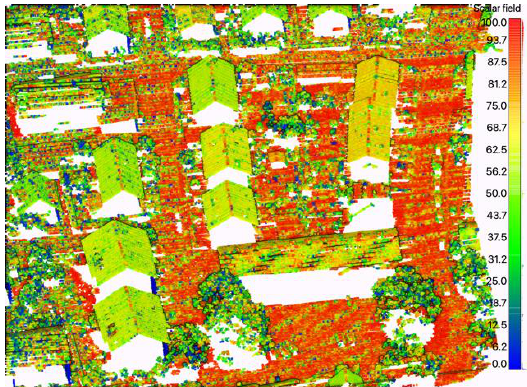
Figure 7. Computed vertical angle feature shown on part of the Vaihingen’s training data. Unit of the legend is grad. 3.2.4